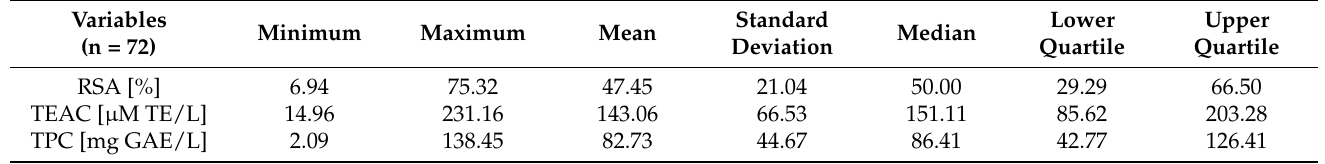
Table 2. Descriptive statistics of the tested